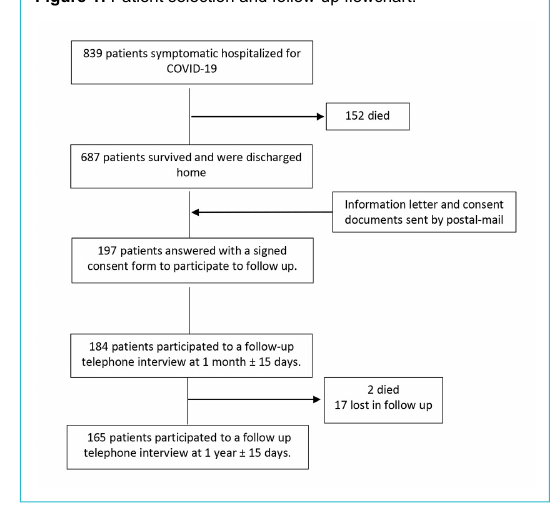
Figure 1: Patient selection and follow-up